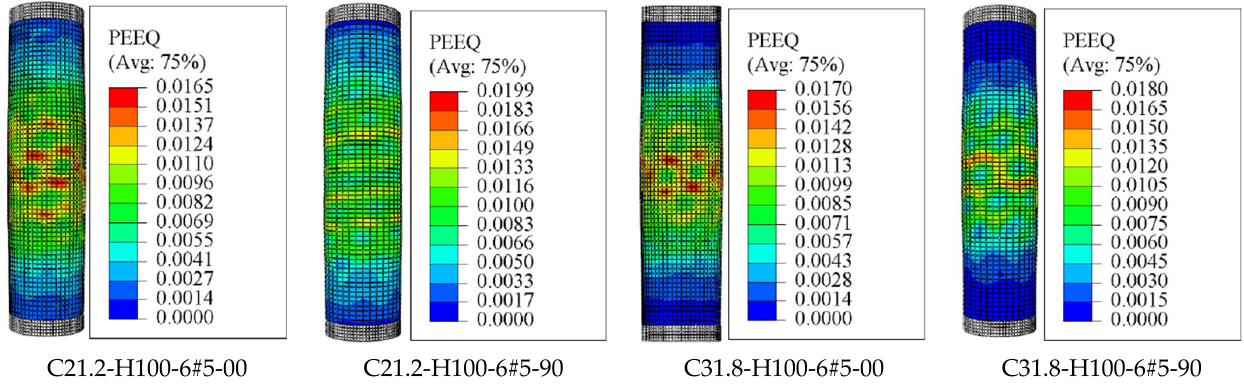
Figure 12. Finite element (FE) failure patterns: Considering the effect of different inner diameters.